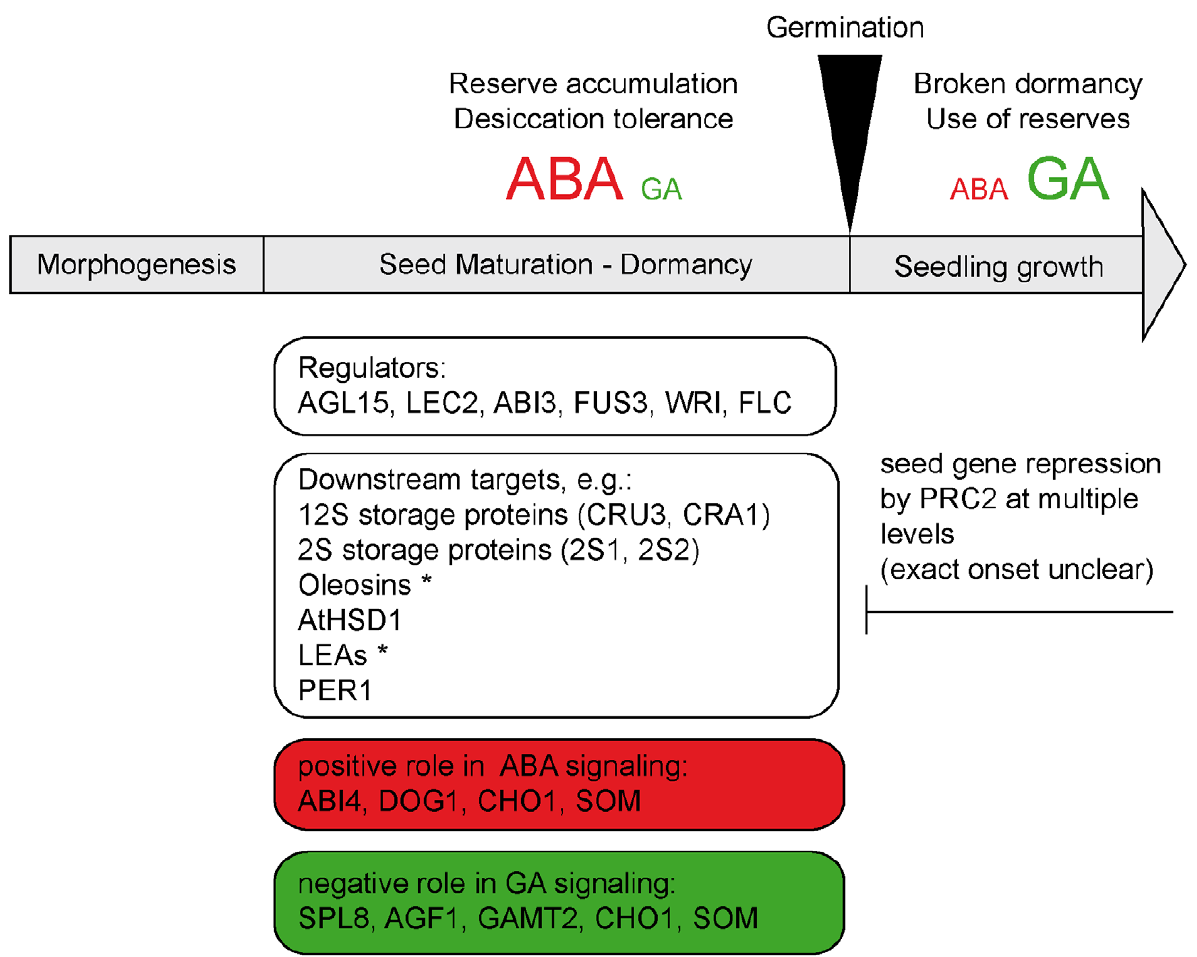
Figure 5. PRC2 represses seed maturation and dormancy genes in the seedling. All genes provided in this model have been identified as H3K27me3 targets and were significantly up-regulated in fie mutants. They include master regulators of seed development such as AGL15 , LEC2 , ABI3 , FUS3 , further downstream regulators such as WRI , integrators of environmental signals such as FLC and finally genes involved in seed storage and desiccation tolerance. * For detailed information which members of the oleosins (oil body coat proteins) and LEAs (late embryogenesis abundant proteins) are affected seeTable S5.For LEC2theup-regulationwas onlyobservedinqRT-PCR(TableS4).We findherethatthe ABAand GA hormonalsignalingpathwaysthatplay a pivotal role in the transition form seed to seedling are under PRC2 control since genes playing a positive role in ABA signaling as well as genes with a negative role in GA signaling are H3K27me3 marked in wild type and up-regulated in fie . Large letters stand for high and small for low ABA and GA levels, respectively.Abscisic acid (ABA), Gibberellic acid(GA), AGAMOUS-Like 15(AGL15, AT5G13790), LEAFYCOTYLEDON 2 (LEC2, AT1G28300), ABA INSENSITIVE3 (ABI3, AT3G24650), FUSCA3(FUS3,AT3G26790), WRINKLED1(WRI, AT3G54320), FLOWERINGLOCUSC(FLC,AT5G10140),CRUCIFERIN3(CRU3,AT4G28520), CRUCIFERINA (CRA1, AT5G44120), SEED STORAGE ALBUMIN 1 (2S1, AT4G27140), SEED STORAGE ALBUMIN 2, (2S2, AT4G27150), HYDROXYSTEROID DEHYDROGENASE 1 (AtHSD1, AT5G50600), Peroxiredoxin 1 (PER1, AT1G48130), ABA INSENSITIVE 4 (ABI4, AT2G40220), DELAY OF GERMINATION 1 (DOG1, AT5G45830), CHOTTO 1/AINTEGUMENTA-LIKE 5 (CHO1/AIL5, AT5G5739), SOMNUS (SOM, AT1G03790), SQUAMOSA PROMOTER BINDING PROTEIN-LIKE 8 (SPL8, AT1G02065), AT-hook protein of GA feedback 1 (AGF1, AT4G35390), GIBBERELLIC ACID METHYLTRANSFERASE 2 (GAMT2, AT5G56300).